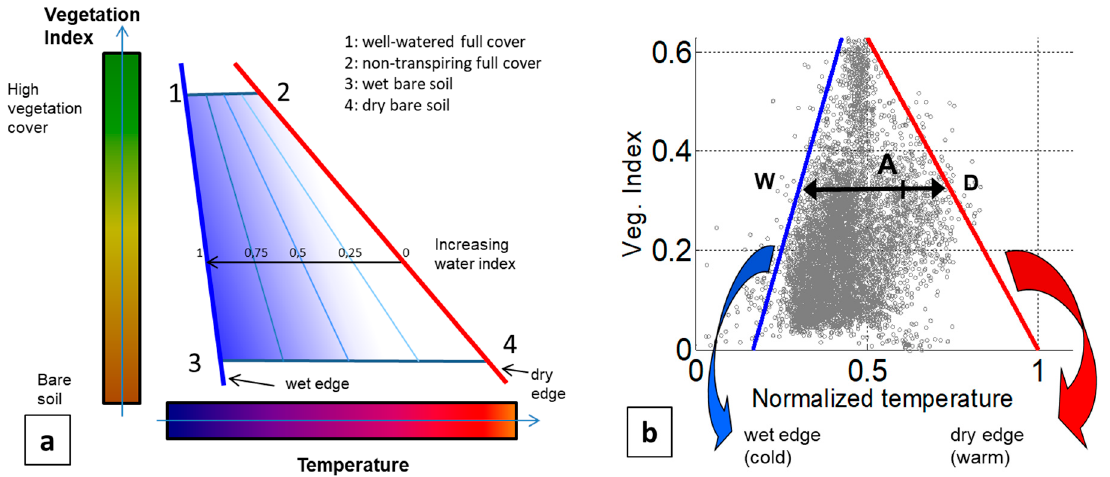
Figure 2. ( a ) Principle of the Triangle/Trapezoid Method with an interpretation of the four vertexes of the T-VI scatterplot (adapted with permission from [24,26]. Copyright 2022 Elsevier). The “dry” and “wet” edges are the “hot” and “cold” (here linear) boundaries of the scatterplot, respectively; they define the 0 and 1 isopleths of the water index. Three other isopleths were added, which correspond to 0.25, 0.5 and 0.75 water index levels. ( b ) Typical 2D scatterplot of (normalized) temperature and vegetation indices obtained during the first campaign.